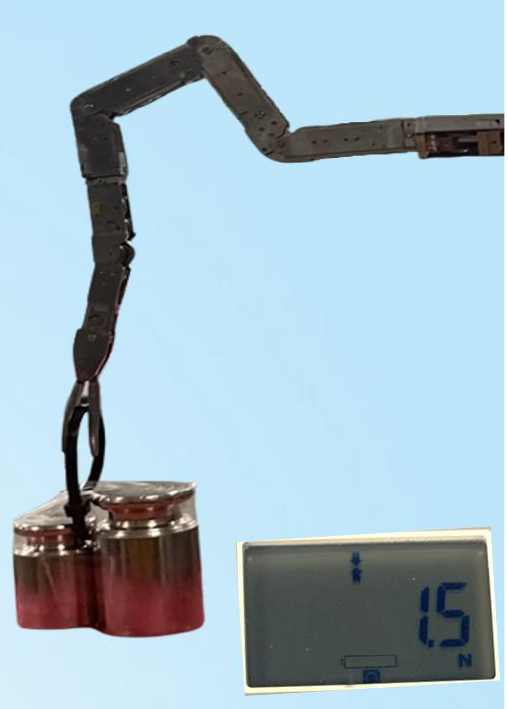
Figure 11. Manipulator with effect load of 1.5 (newton and 0.15 kg with down and